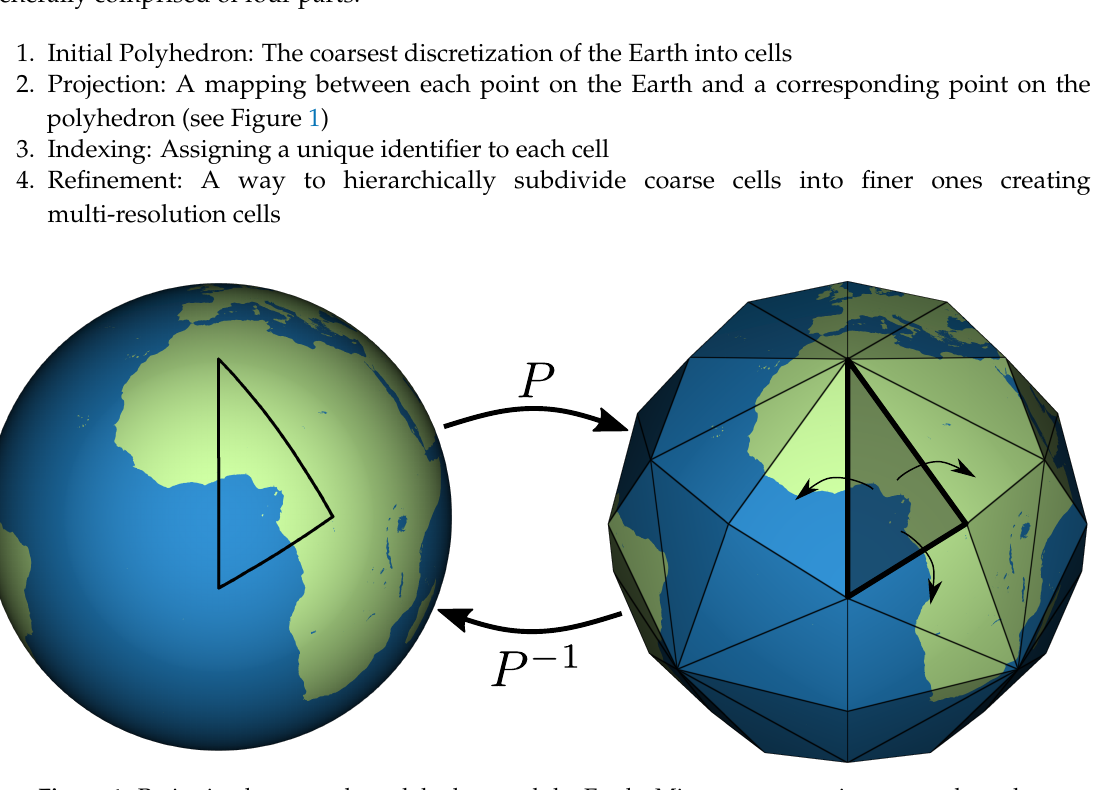
Figure 1. Projection between the polyhedron and the Earth. Mirror symmetry is present along the edges of all adjacent triangles in the Disdyakis Triacontahedron